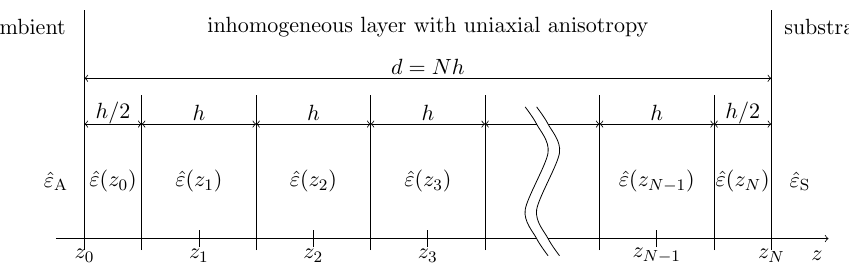
Figure 1. Schematic diagram of the division of the inhomogeneous film into thin homogeneous